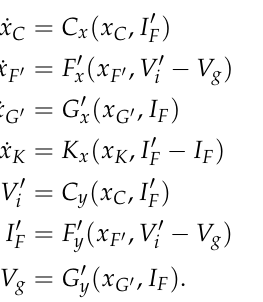
, it can enforce any virtual filter current I (cid:48) i